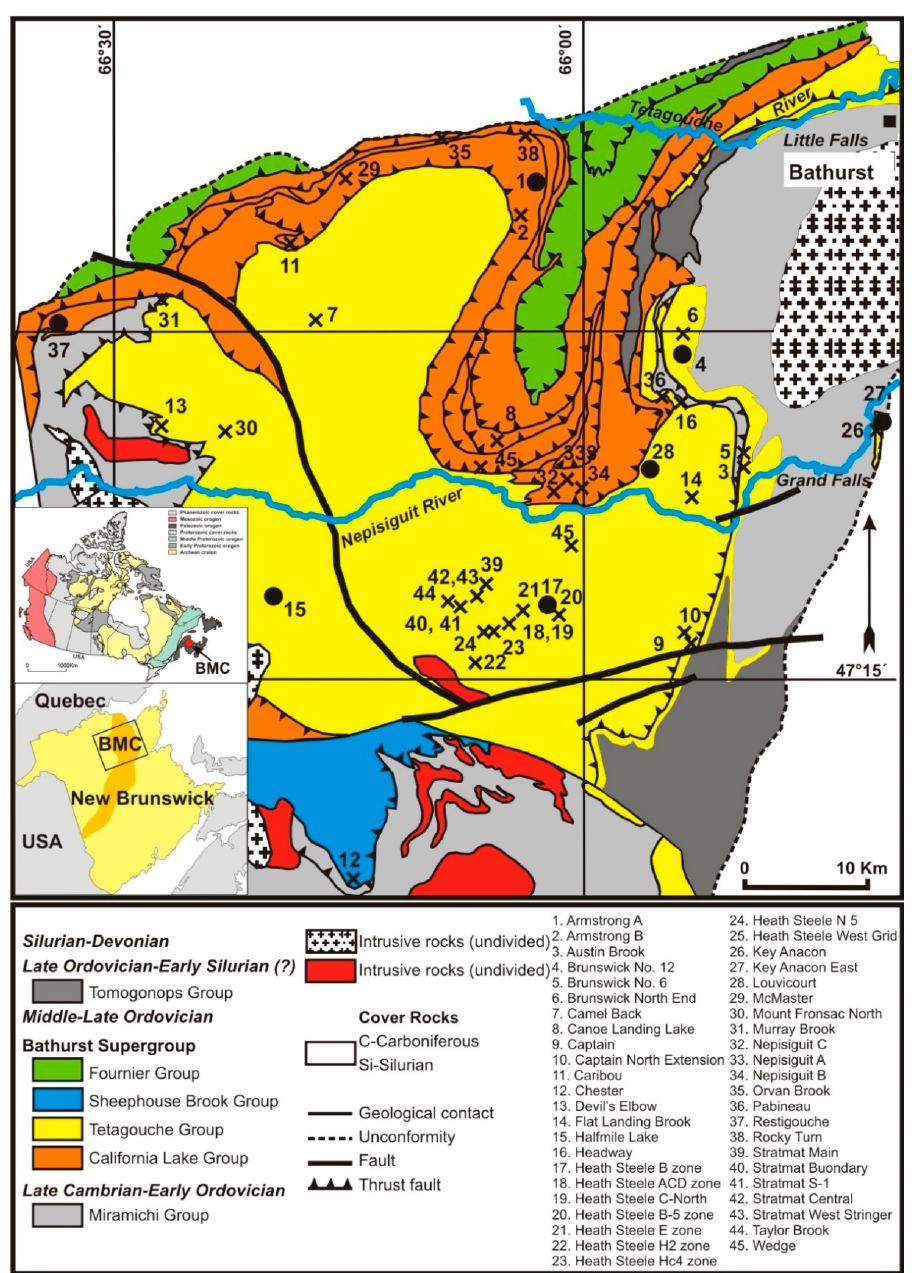
Figure 1. Simplified geological map of the Bathurst Mining Camp, northeastern New Brunswick, showing the location of massive sulfide deposits marked by numbered ( × ) and listed in the legend. Deposits examined during this study are marked by numbered black filled circles and listed in the legend (modified from [12]). Geological maps of the studied deposits, as well as drill-hole profiles, are provided by [27].